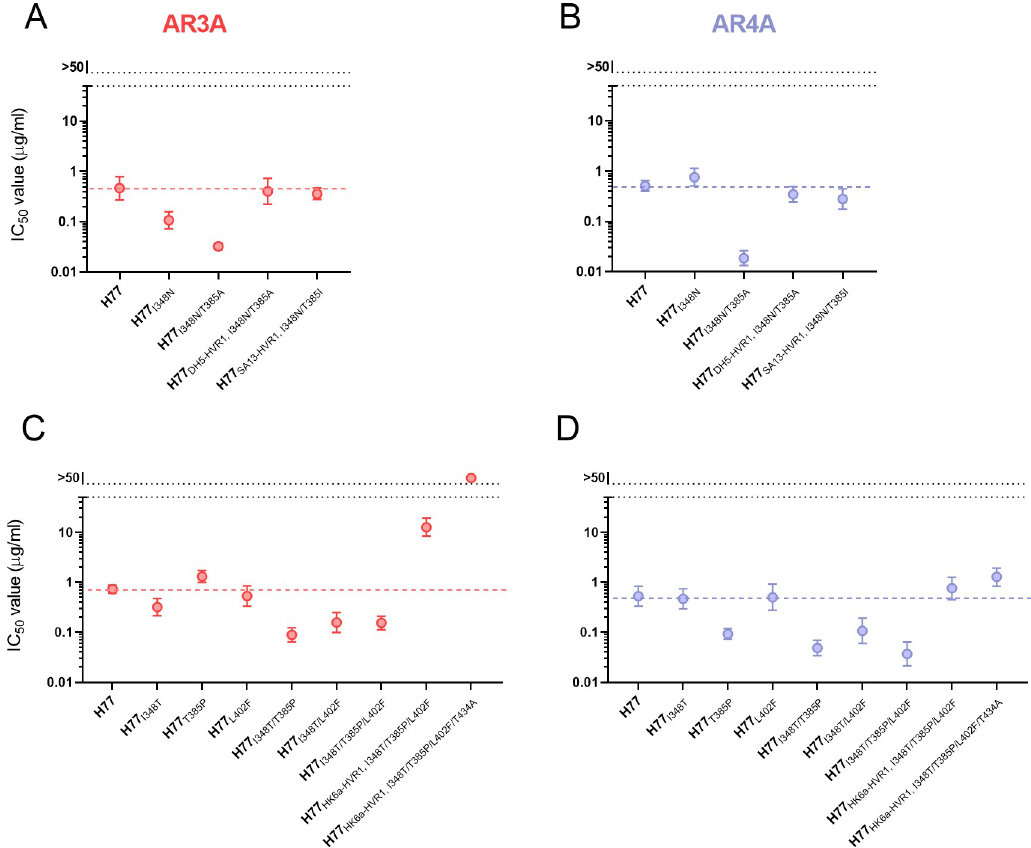
Fig 5. E1/E2 substitutions identified in HVR1-swapped H77 recombinants increase sensitivity of H77 to AR3A and AR4A. Neutralization by the bNAbs AR3A (A and C) and AR4A (B and D) of the indicated HCV recombinants. The viruses were incubated in four technical replicates with a 5-fold dilution series of the bNAbs, starting at 50 μ g/ml, along with eight technical replicates of virus only. 48 hours post-infection the cells were immunostained for HCV antigen, and the number of FFUs/well was counted and normalized to the mean count of wells with virus only. Each dot represents the mean IC 50 value of the indicated recombinants. Error bars represent the 95% confidence intervals (CI 95 ). The colored broken line represents the IC 50 value of unmodified H77. The data was analyzed using three-parameter dose-response with the top value set to 100 and lower value set to 0, to calculate IC 50 and CI 95 using GraphPad Prism